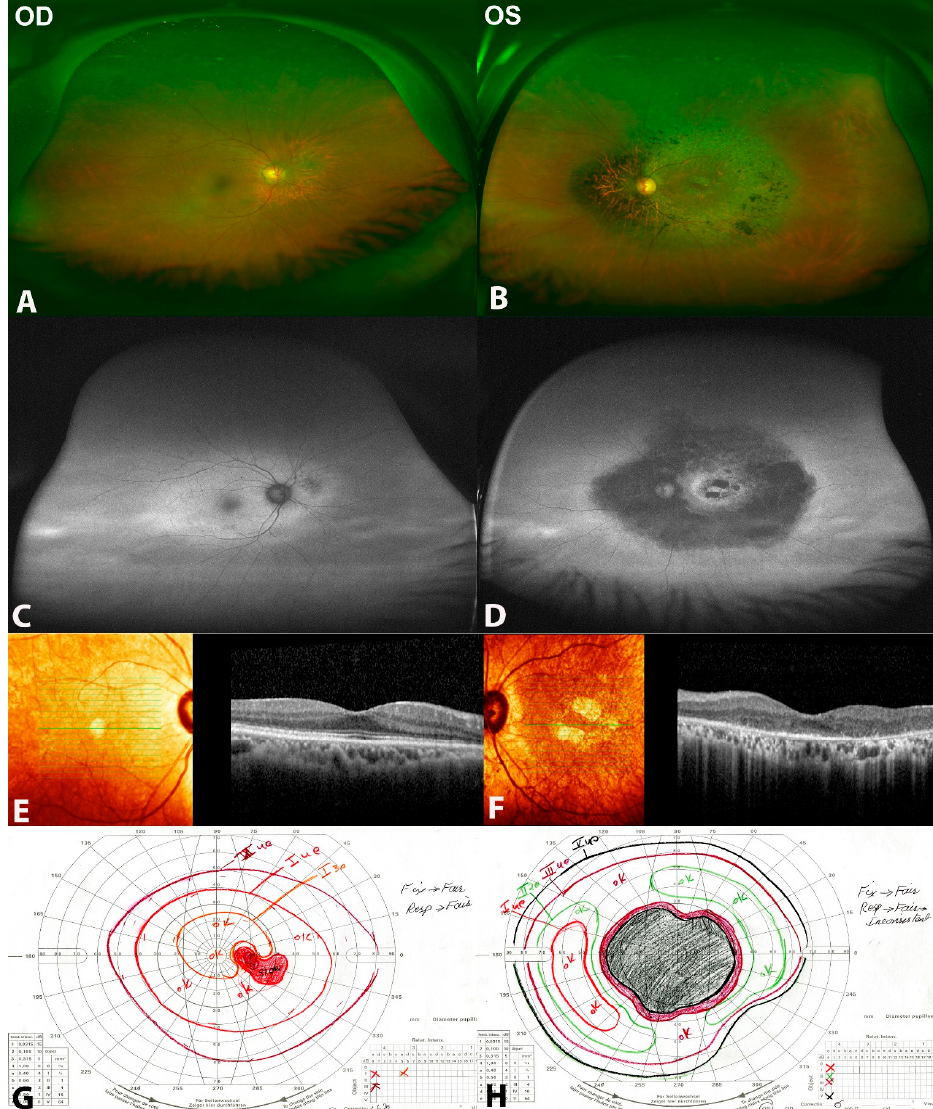
Figure 3. Clinical and multimodal findings of (patient 2) a 65-year-old male with URP in the left eye with the RPGR missense variant c.1286 C>T (p.Pro429Leu). ( A ) and ( B ) are color fundus photos showing chorioretinal atrophic changes nasal to the optic disc in the right eye, while showing midperipheral bone spicules, localized retinal thinning nasal to the optic disc, attenuated blood vessels, waxy pallor of the optic disc and atrophic macula in the left eye. ( C ) and ( D ) are fundus autofluorescence photos showing a ring of hyperautofluorescence around the optic disc in the right eye and hypoautofluorescence in the posterior pole around the disc and macula, hyperautofluorescent ring at the macular area with patches of well demarcated hypoautofluorescence in the left eye. ( E , F ) show SD-OCT of the right eye as normal, while in the left eye shows loss of ellipsoid zone, macular thinning with reverse shadowing. ( G , H ) are Goldman visual fields of both eyes showing normal visual field in the right eye and a large central scotoma in the left